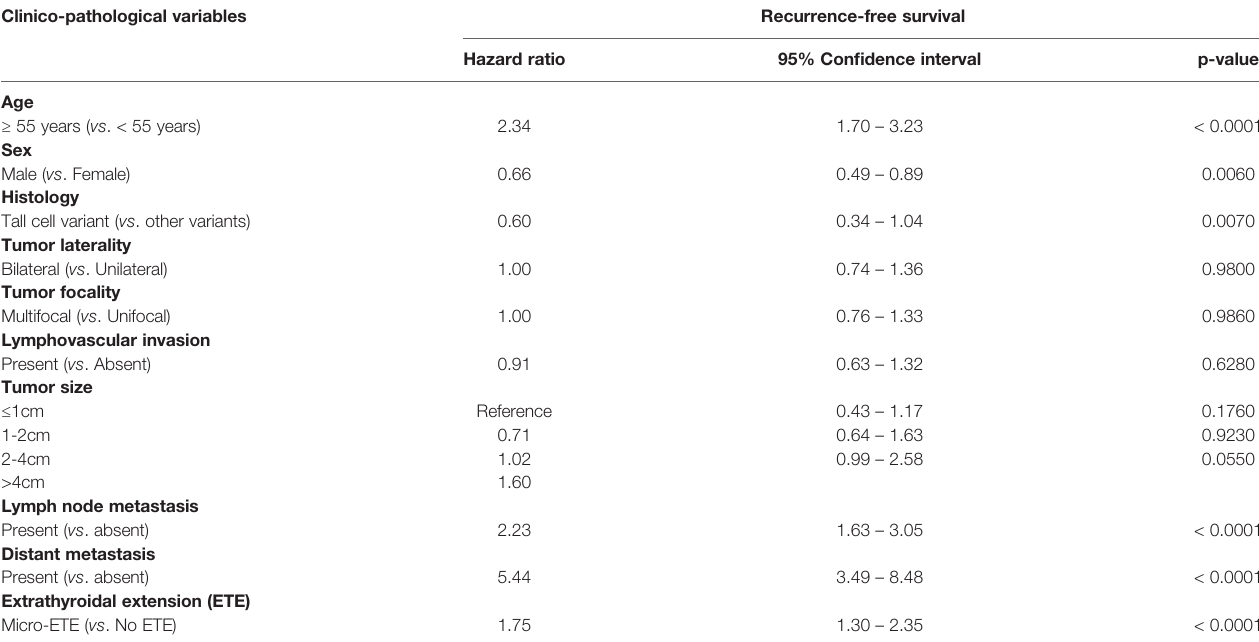
TABLE 3 | Multivariate analysis of microscopic extrathyroidal extension using Cox Proportional Hazard Model for Recurrence-free survival. Clinico-pathological